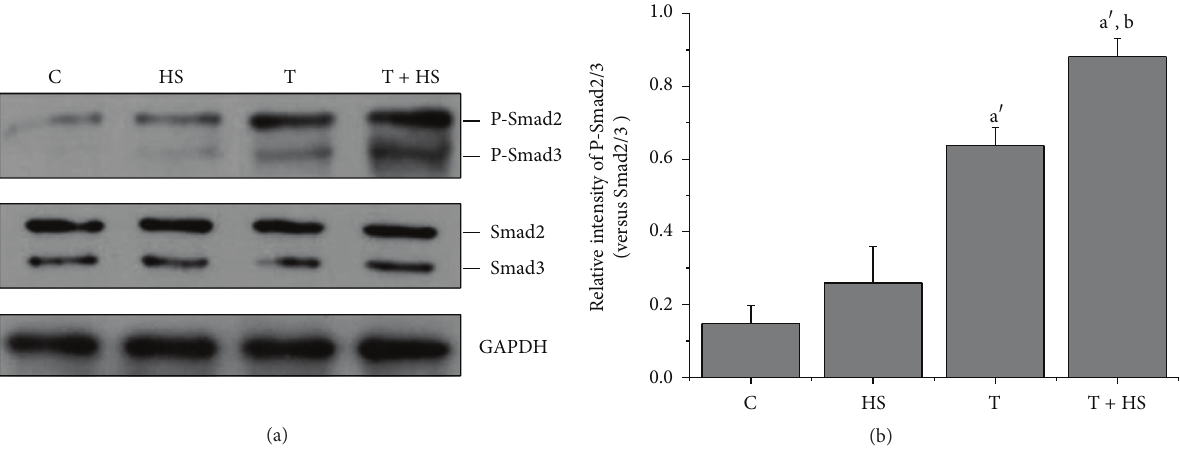
Figure 3: HS strengthens TGF- 𝛽 3-mediated Smad2/3 phosphorylation. Cells were cultured in four different media (C, HS, T, and T + HS) and were harvested at 24 h. (a) Western blot for protein levels of P-Smad2/3, total Smad2/3, and GAPDH. (b) Quantification of protein levels of P-Smad2/3 normalized to total levels of Smad2/3. Error bars represent the means ± SD, 𝑛 = 3 . a T group.